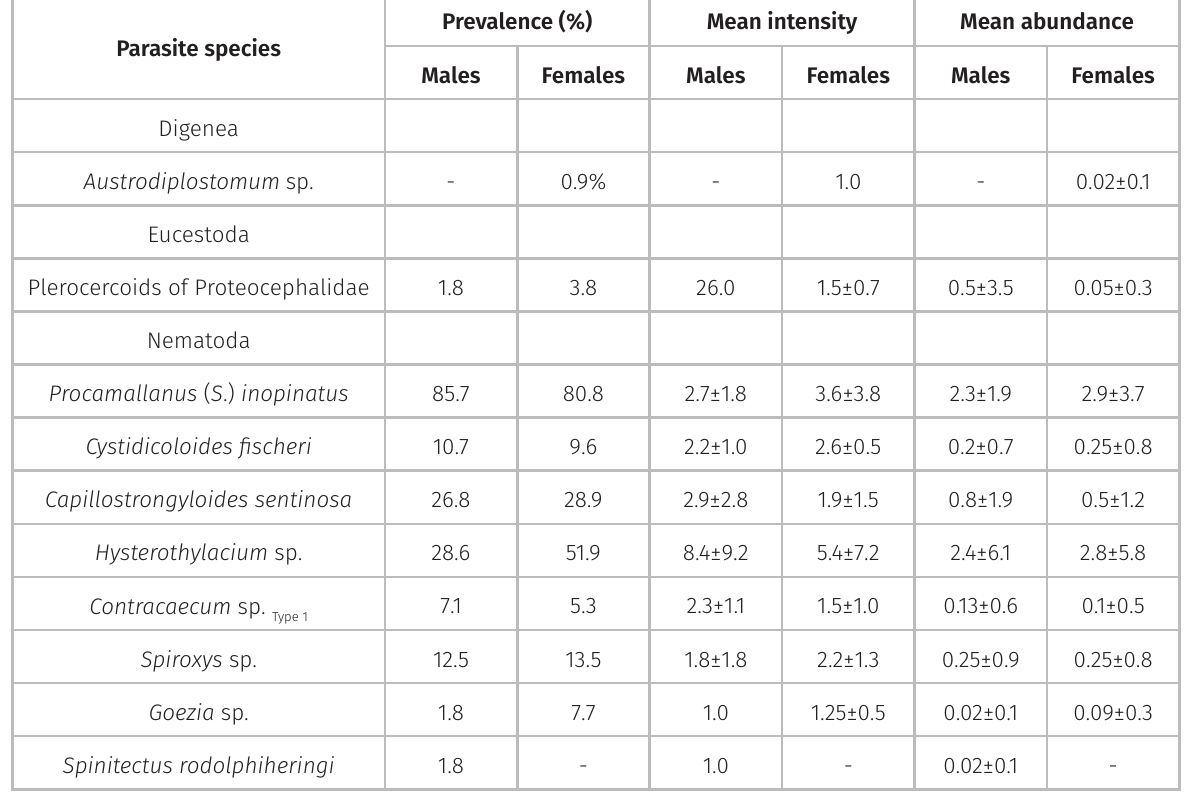
- Impossible to calculate because no male fish was parasited by Austrodiplostomum sp. and no female fish was parasited by Spinitectus